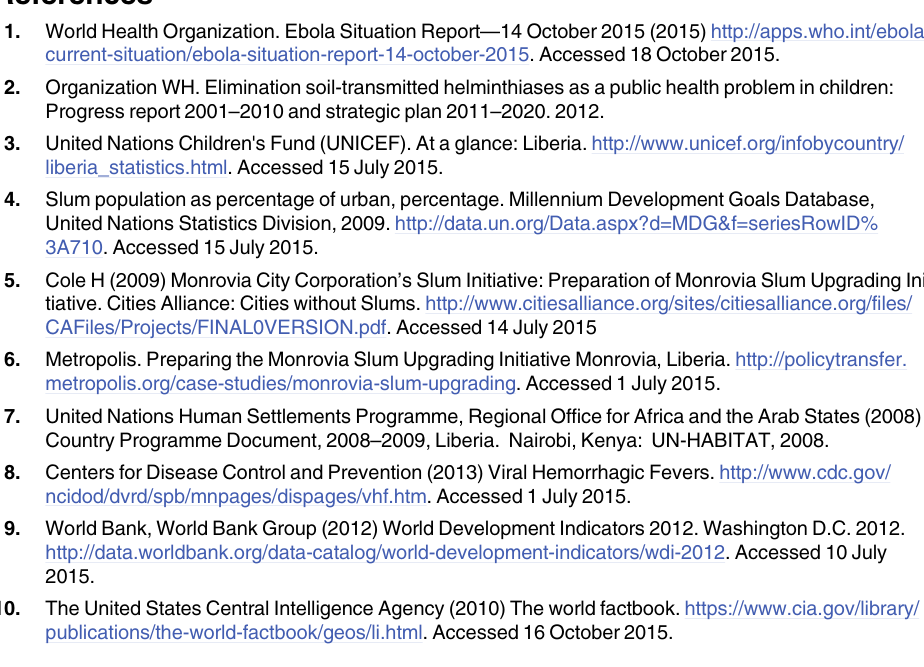
S2 Fig. Frequency distributions for the number of contacts per case from case investigation data. Data are provided per epidemic month in 2014. S3 Fig. Frequency distributions for time between symptom onset and hospitalization from case investigation data. For each individual reporting current or prior hospitalization, the number of days between his/her date of symptom onset and date of hospital admission was cal- culated. Data are provided per epidemic month in 2014. S4 Fig. Frequency distributions for time between symptom onset and death from case investigation data. For each non-surviving case, the number of days between his/her date of symptom onset and date of death was calculated. Data are provided per epidemic month in 2014. S5 Fig. Histogram of a truncated gamma distribution for the rate ratio, or expected change in transmission rate given a tenfold change in viral load. S6 Fig. Temporal trends in Ebola-related behaviors and case fatality, stratified by socioeco- nomic status (SES). Data are provided per epidemic month in